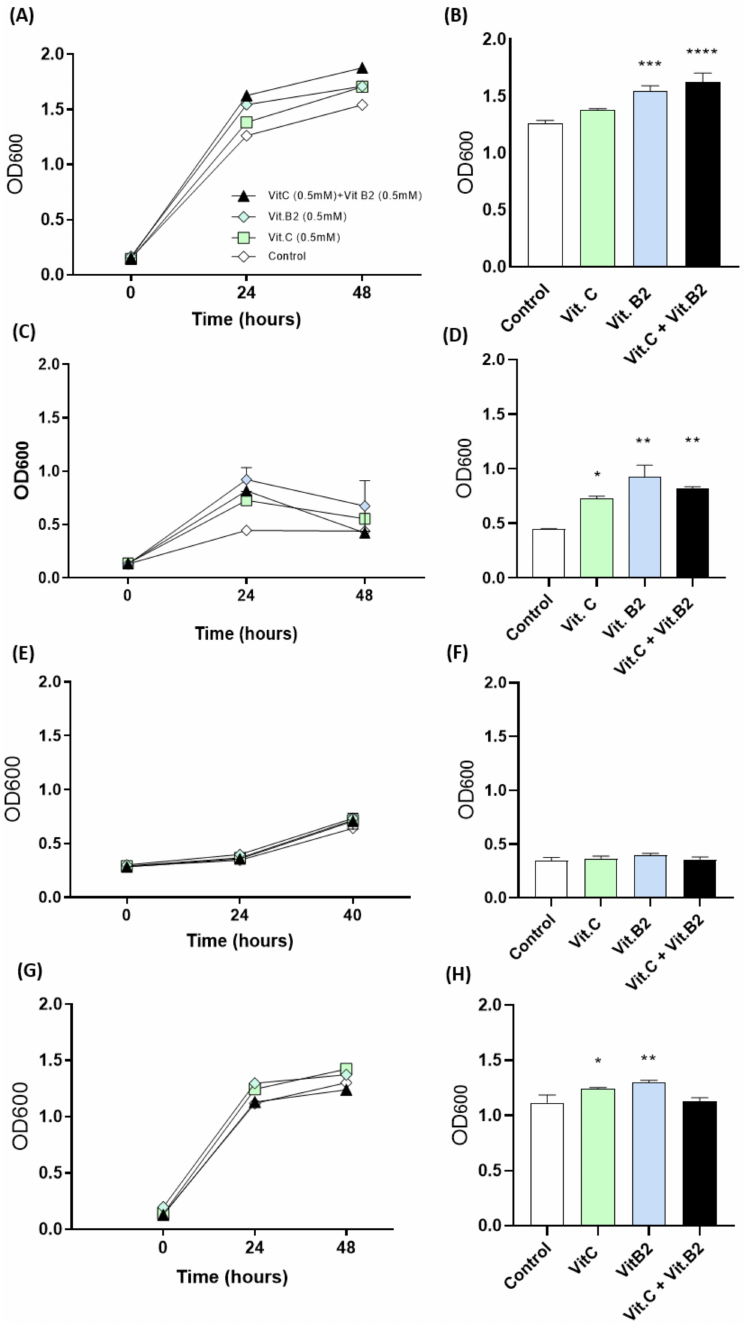
Figure 2. The effect of vitamins B2 and C on the growth of B. coccoides ( A , B ), R. intestinalis ( C , D ), E. coli ( E , F ) and E. faecalis ( G , H ). Bacteria stimulated with 5 mM of vitamin C and vitamin B2, alone or in combination, were grown under oxidative conditions for 48 h. Optical density measurements (600 nm) at 0, 24 and 48 h of incubation ( A , C , E , F ) and changes between groups were represented separately after 48 h of incubation ( B , D , F , H ). All data are presented as mean ± SEM. * (p < 0.05) , ** ( p < 0.01), *** ( p < 0.001) and **** ( p < 0.0001) represent the significant changes between non-supplemented bacteria (control) and supplemented bacteria (N =